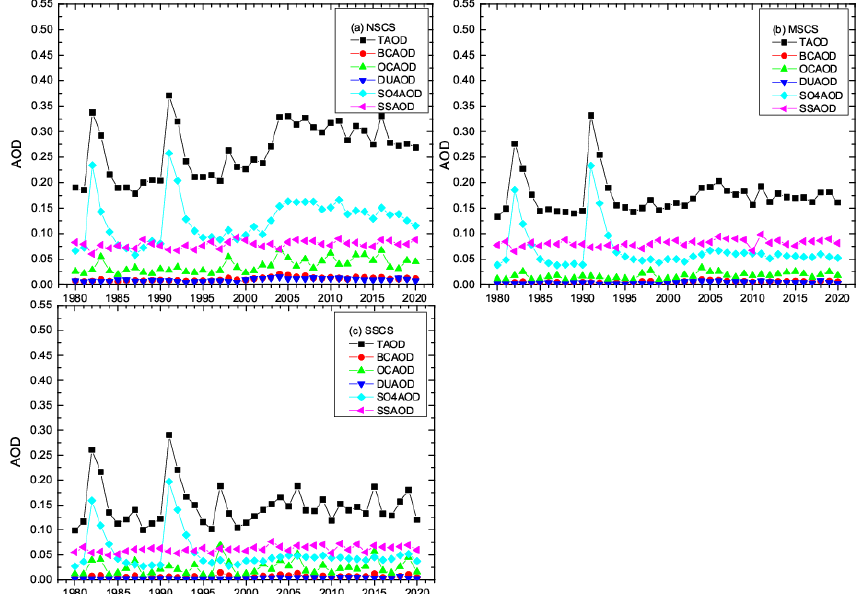
Figure 8. Variation of annual mean values of TAOD, BCAOD, OCAOD, DUAOD, SO 4 AOD, and SSAOD over ( a ) NSCS, ( b ) MSCS, and ( c ) SSCS during the period of 1980–2020.